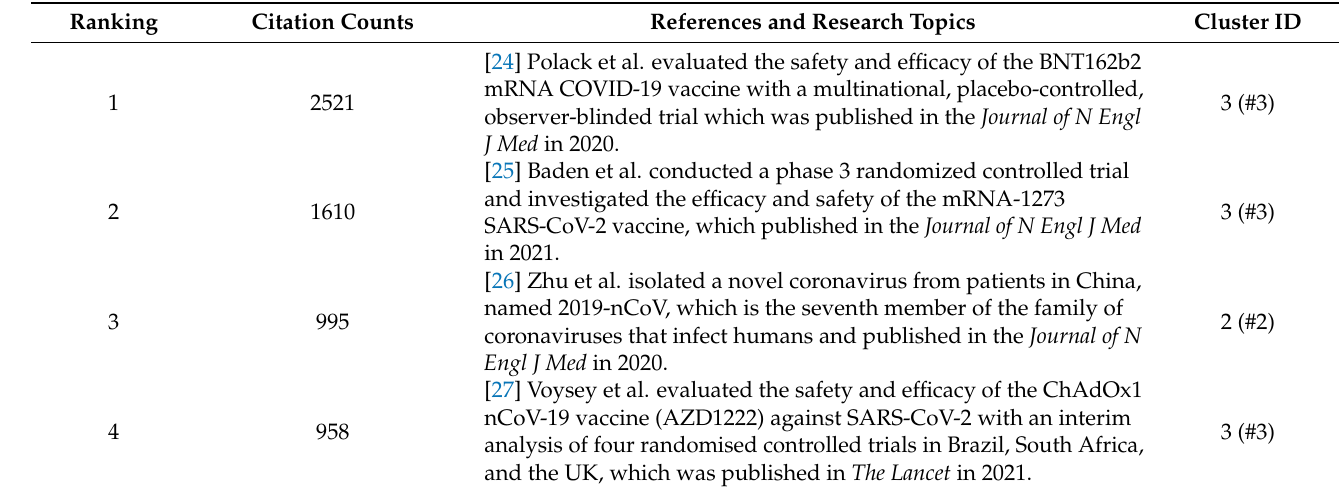
Table 5. Top 10 highest-citation documents on COVID-19 vaccine